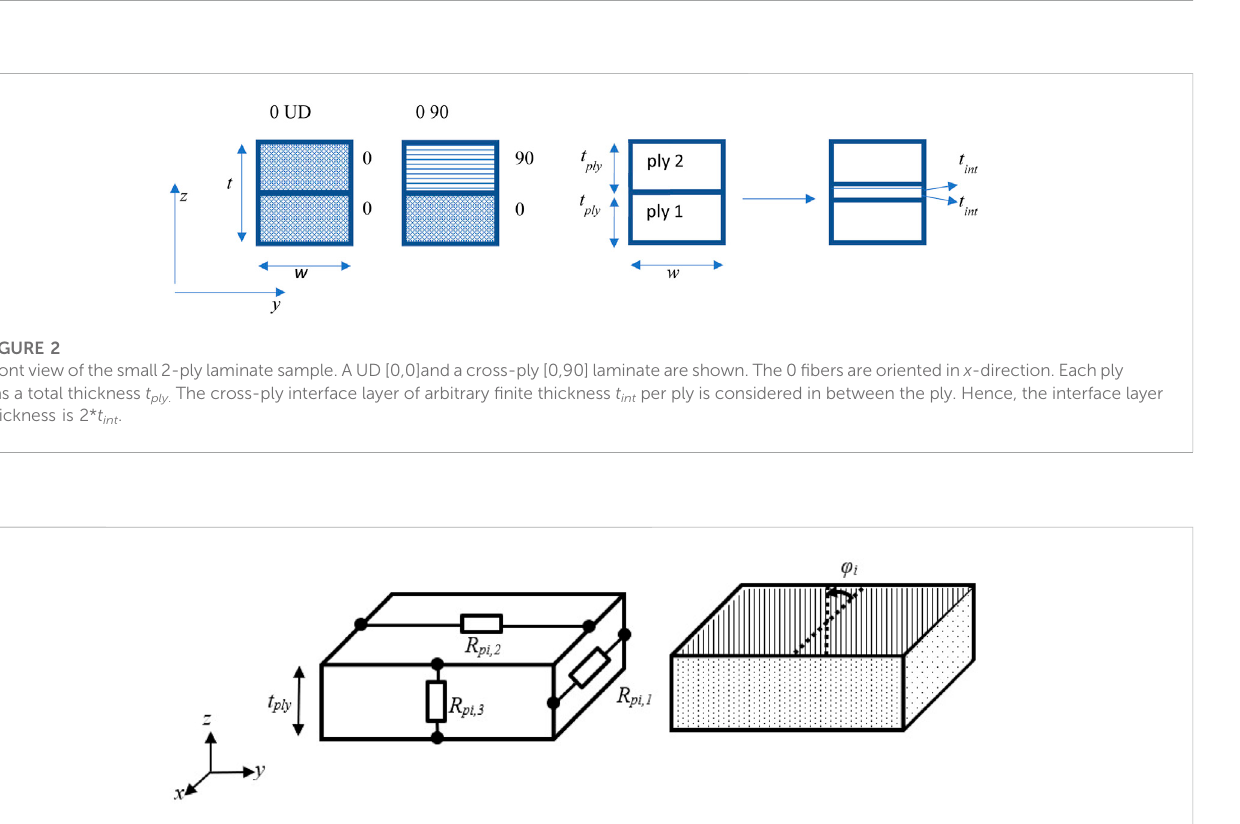
FIGURE 3 Illustration of the anisotropic resistances (left) and fi ber orientation expressed by ply angle φ i (right) for a single ply in the small laminate sample.